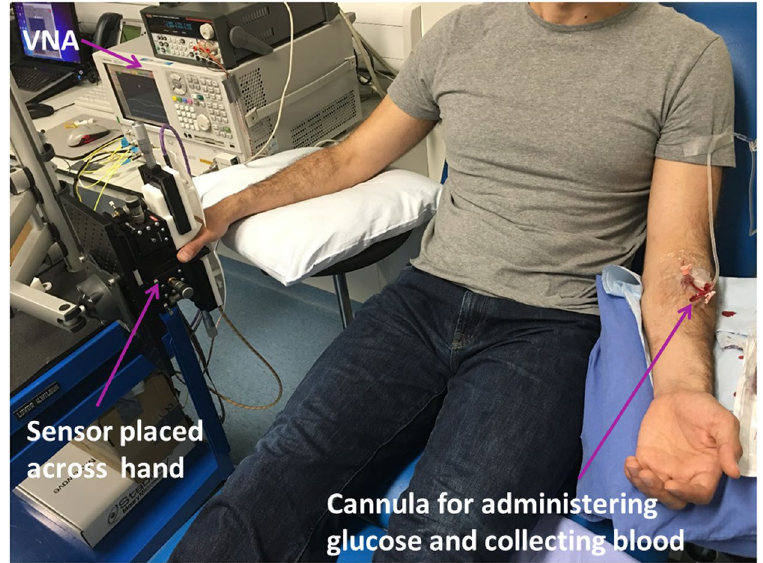
Figure 9. The setup for in-vivo glucose measurements in humans. The non-invasive system is placed across the thin tissue of right hand. Glucose was administered intravenously through the left arm. The same cannula was used to collect blood samples for measuring glucose levels during a specific amount of